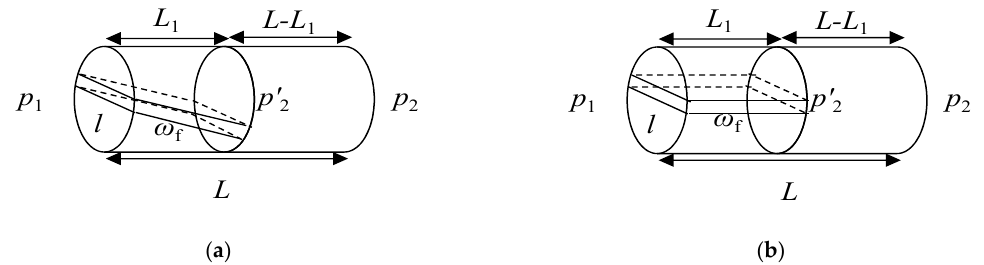
Figure 5. The sketch of a fracture-penetrated core ( a ) with an oblique fracture and ( b ) after an equivalent fracture is made. l is the width of the fracture (equal to the diameter of the section surface) (cm); ω f is the fracture opening equal to the distance of the two surfaces of the fracture (cm); L 1 is the equivalent length of the fracture (cm); L is core length (cm); p 1 is the absolute pressure on the inlet section (MPa); p 2 is the absolute pressure on the outlet section (MPa); p' 2 is the absolute pressure on the outlet section of the penetrated part (MPa); and the fracture penetration extent is L 1 / L